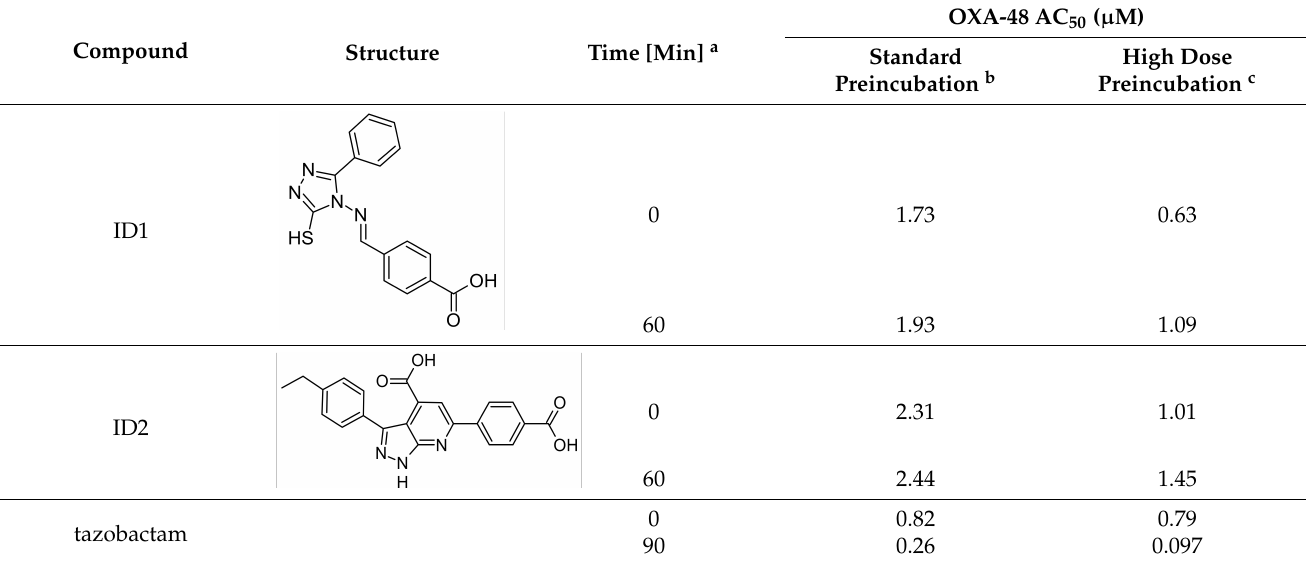
Table 2. Dilution after preincubation with ID1 , ID2 , and tazobactam .